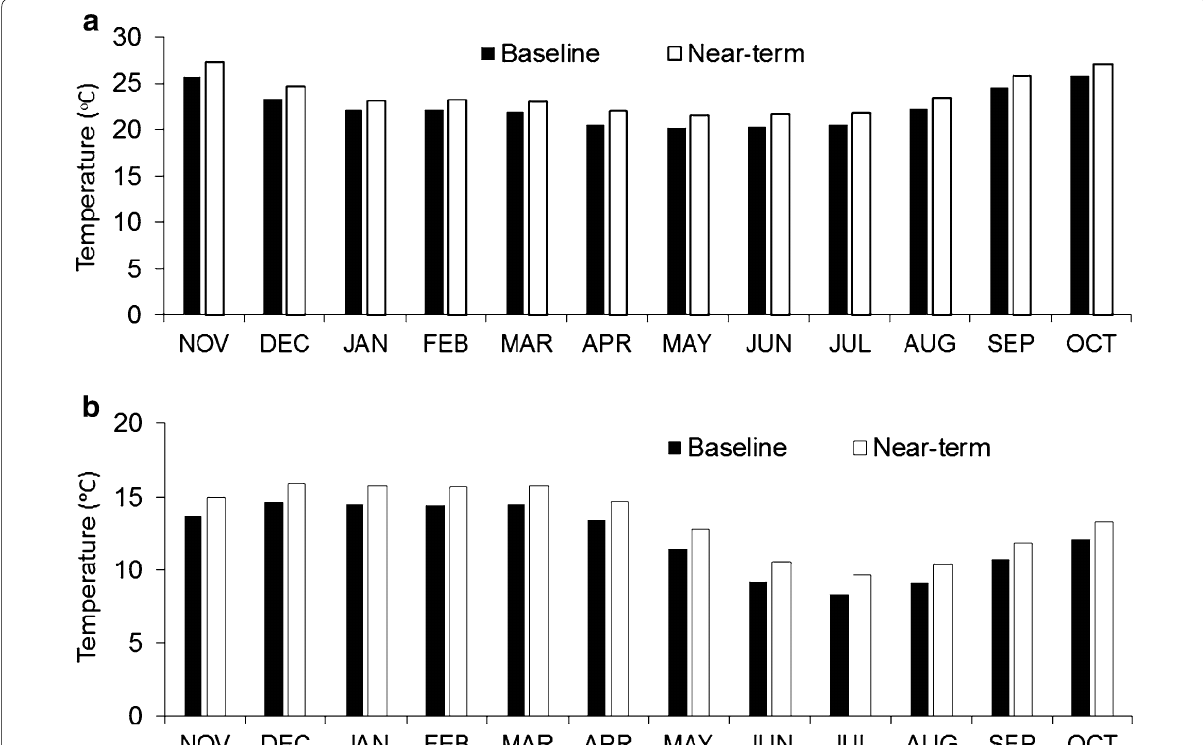
Fig. 17 Average monthly maximum ( a ) and minimum ( b ) temperature of Ndembera watershed for baseline and near-term